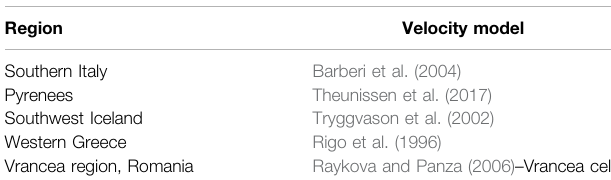
TABLE 3 | Regional velocity models used in this study. Region Velocity model Southern